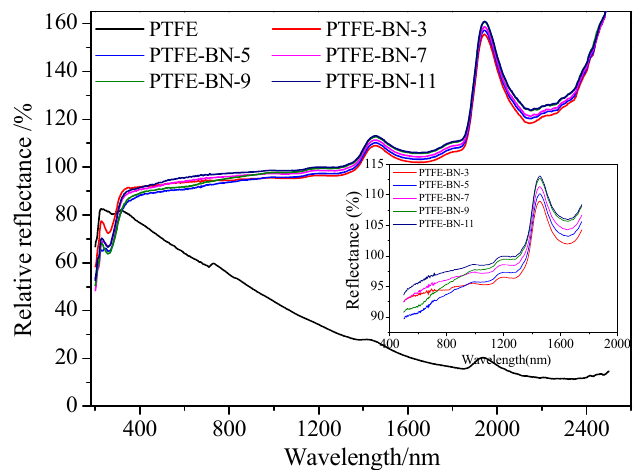
Figure 5. Spectral reflectance of PTFE and PTFE/BN specimens.